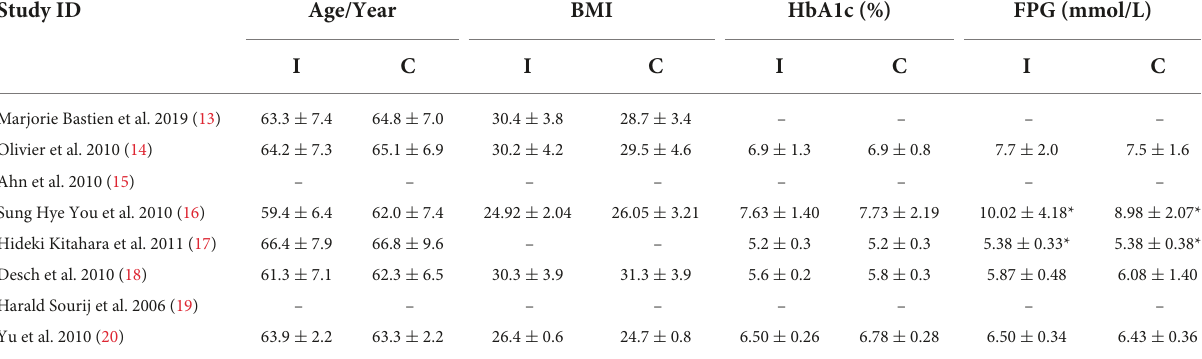
TABLE 2 Baseline condition for the included experimental population.